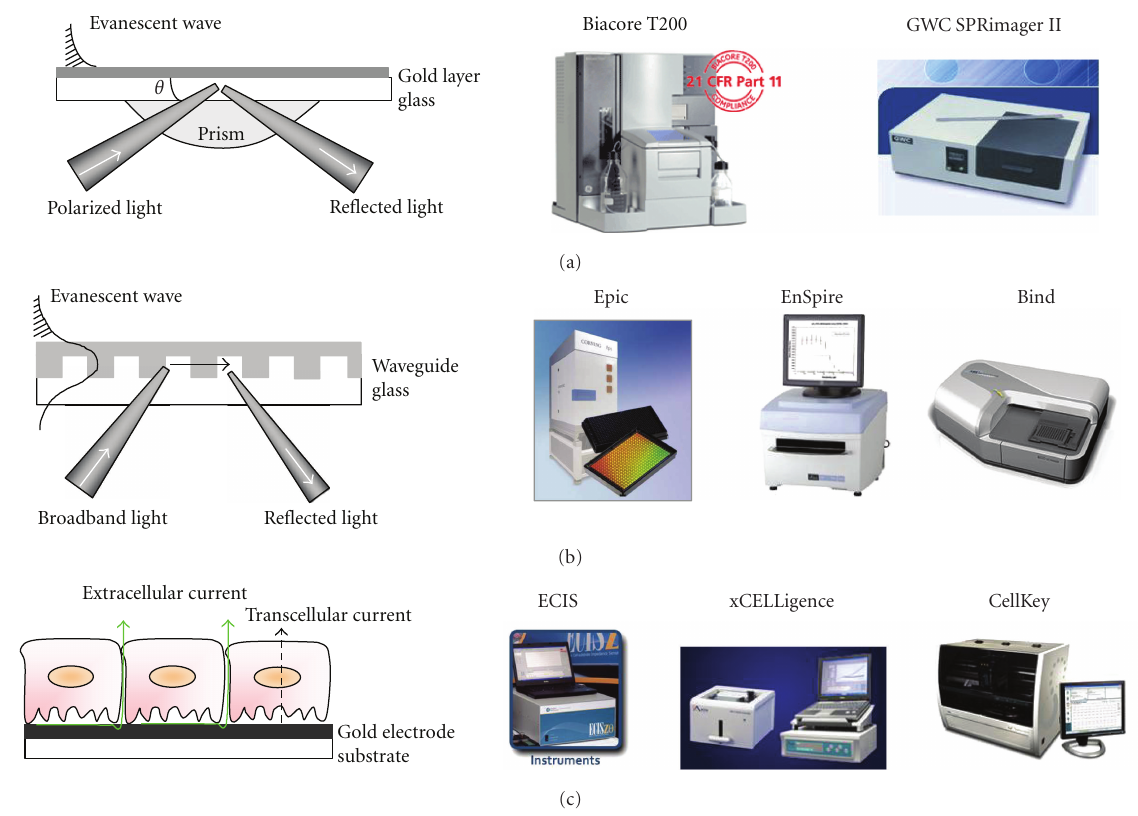
Figure 2: Principles and commercial instruments of three distinct types of label-free biosensors. (a) Surface plasmon resonance, which uses light excited surface plasmon polaritons to sense whole cells. Biacore SPR T200 and GWC SPRImagerII are two examples of